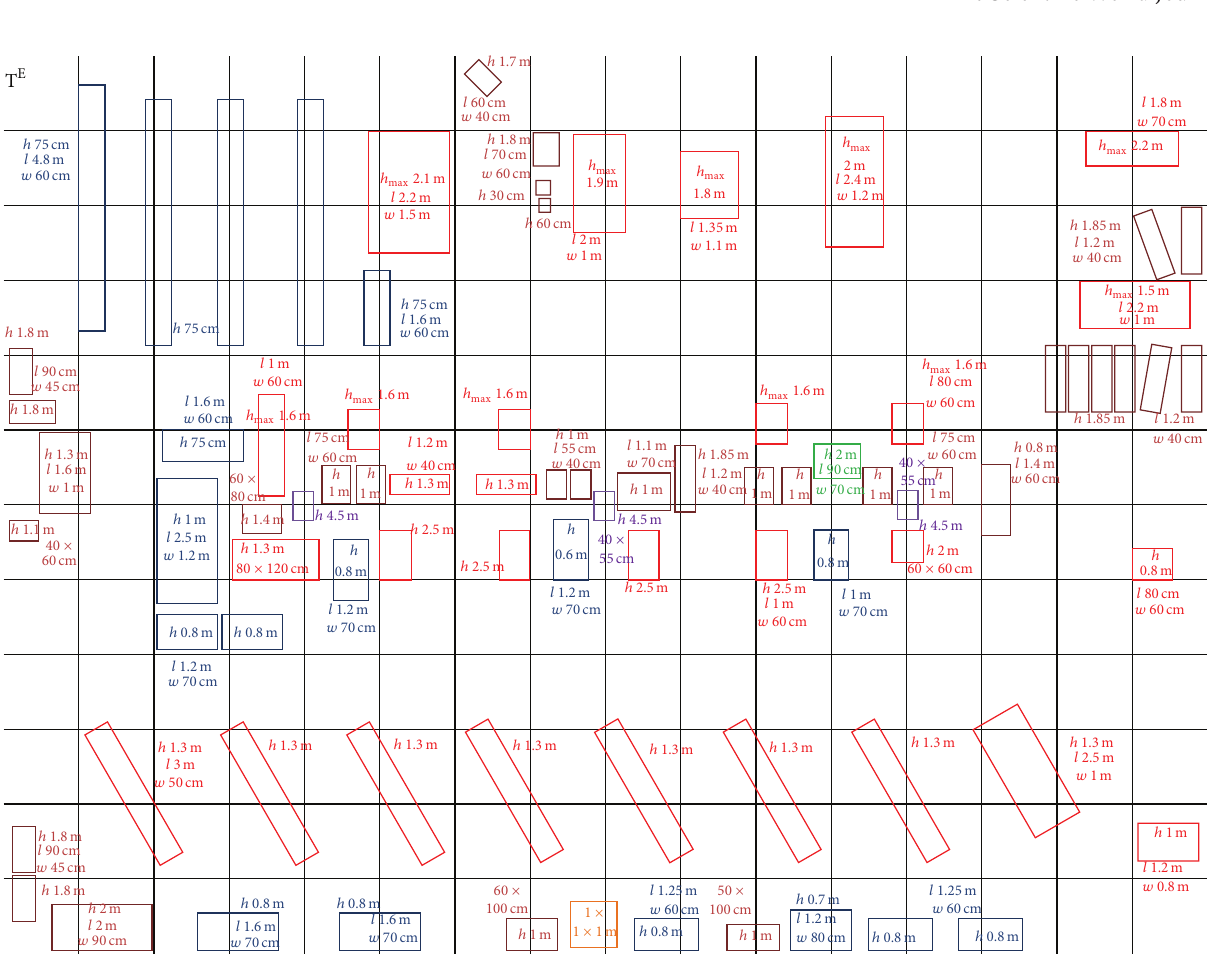
Figure 1: Industrial hall with various types of obstacles (test grid), 𝑙 = obstacle length, 𝑤 = obstacle width, ℎ = obstacle height, and ℎ max = maximum obstacle height. Table 1: First measurement set of RSSI values in the test grid (R-row,